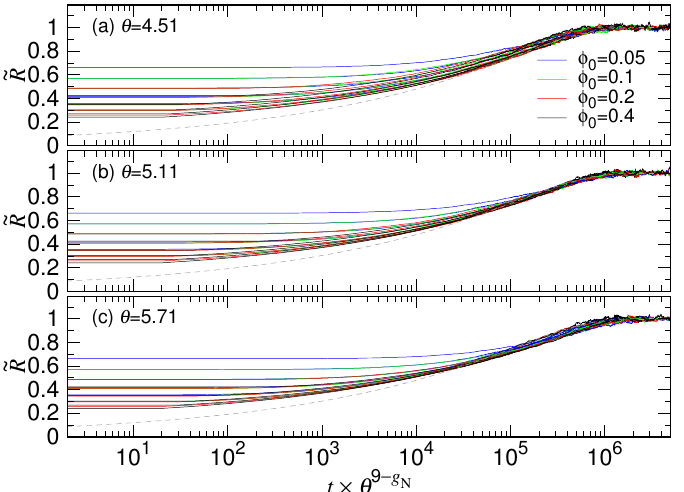
Figure 6. Normalized chain size ˜ R vs. the scaled time t × θ 9 − g N plotted for different chain length N = 2 g N and φ 0 = 0.4 × 2 − g F by using ( a ) θ = 4.51, ( b ) θ = 5.11, and ( c ) θ = 5.71. The confining volume fraction φ 0 is given in the legend. The dashed line is the master curve for the second stage, fit from the data in ( b ) in the region with t × θ 9 − g N > 3 × 10 5